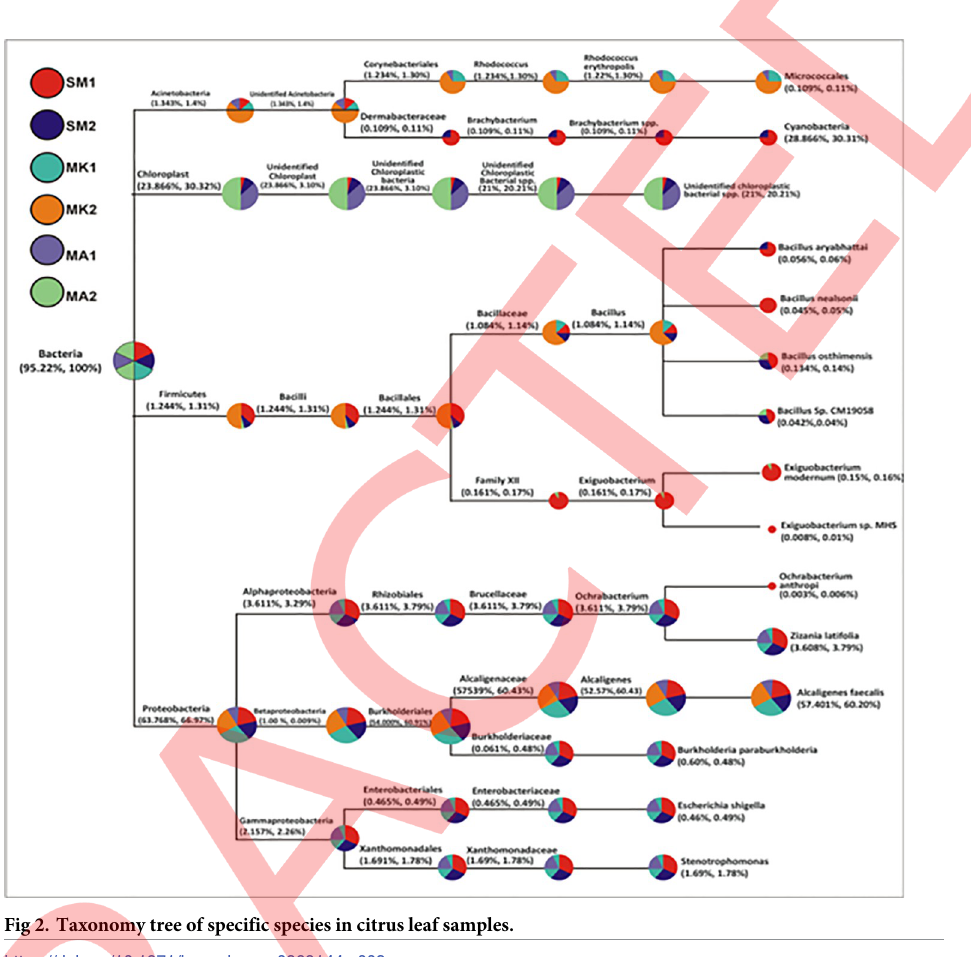
Fig 2. Taxonomy tree of specific species in citrus leaf samples.